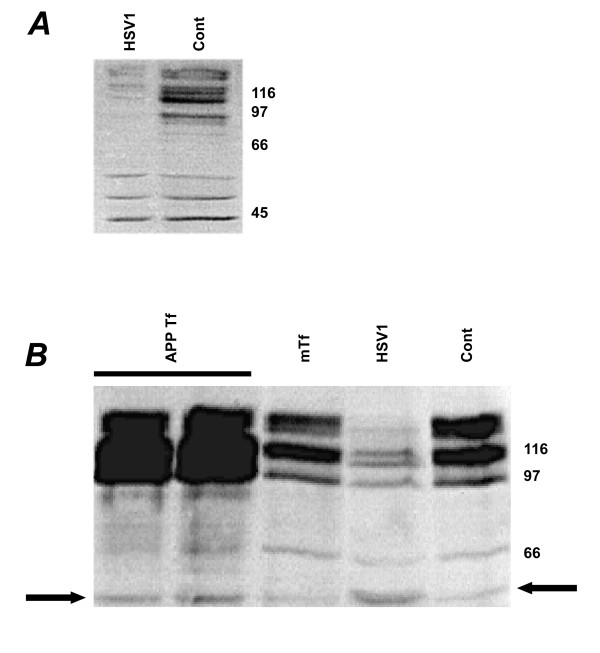
Absence of N-terminal fragment and confirmation that 55 kDa fragment is derived from APP. (A) Staining with antibody to N-terminal APP. SHSY5Y human neuroblastoma cells were either untreated (cont) or infected with HSV1, then incubated for a further 6 h. Cell lysates were analysed by Western blotting using an anti-N-terminal APP antibody 22C11. No evidence for increase in an N-terminal fragment of the expected M Wt. was observed, suggesting the latter may be metabolised further or secreted. (B) Strengthening of 55 kDa band in uninfected APP-transfected SHSY5Y cells. Normal SHSY5Y human neuroblastoma cells, mock-transfected SHSY5Y cells (mTf) or APP695 transfected cells (APP Tf) were uninfected prior to harvest. In addition normal SHSY5Y cells which had been infected with HSV1 (lane labelled HSV1) for 6 h were also prepared, to allow position of the HSV1-senstive 55 kDa band to be clearly identified. Cell lysates were subjected to Western blot analysis, and probed with an anti-C-terminal APP antibody (Sigma Aldrich A8717) at 1:4000 dilution. Arrows indicate the position of the band intensified after HSV1 infection. The intensity of full-length APP bands was appreciably greater than those in the non-transfected cells. In addition the intensity of several smaller bands was also greater than the intensity of the same bands in the mock-transfected (mTf) or normal SHSY5Y (cont), including a band at the same position as the band intensified on HSV1 infection of normal SHSY5Y cells (marked by the arrows), suggested this band is genuinely derived from APP.